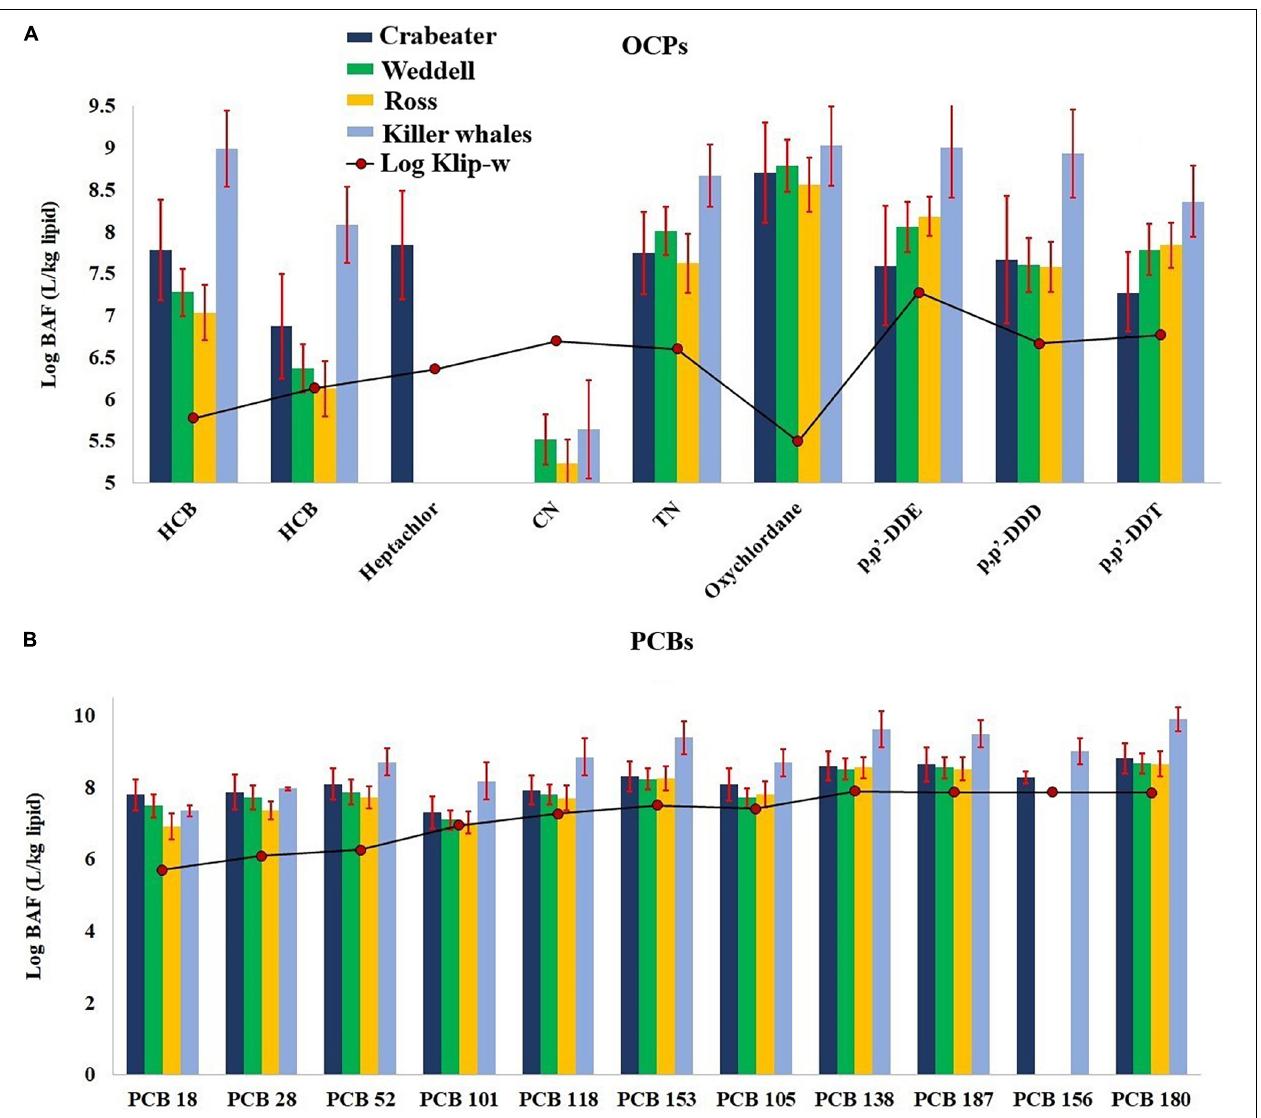
FIGURE 4 | Log BAF-log K lip − w relationship for OCPs (A) and PCBs (B) in the seal and killer whale samples collected from western Antarctic. Error bars represent the standard deviation. See Table 1 for sample size in each